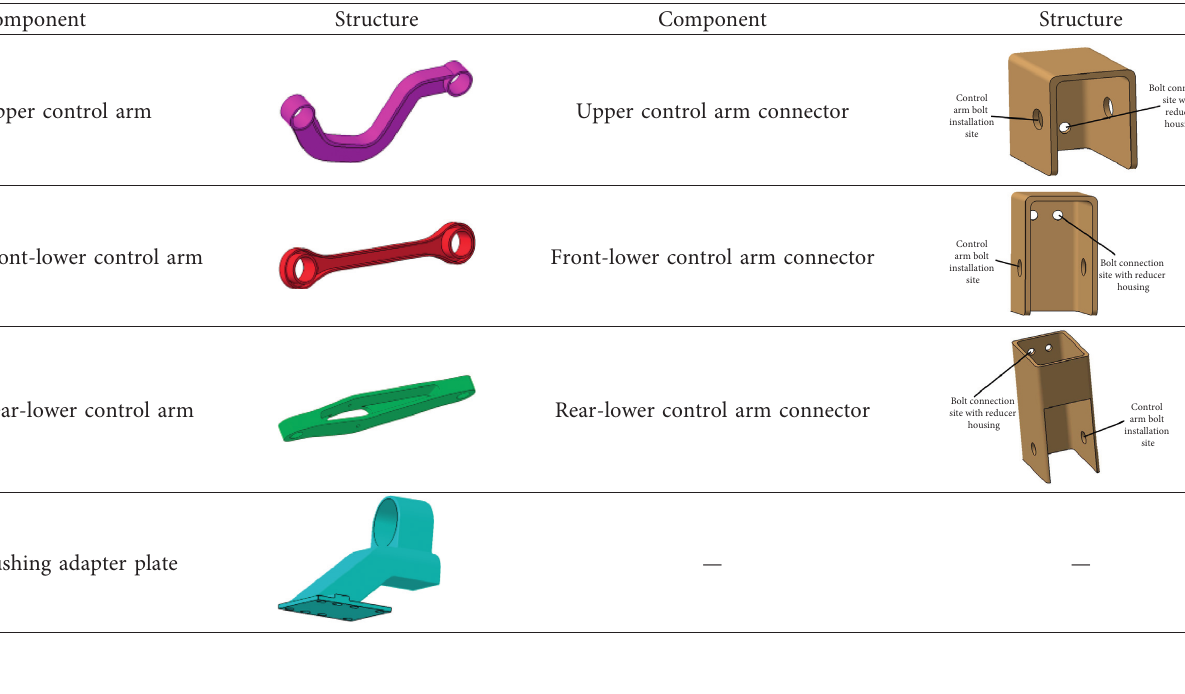
Table 14: Overall vehicle parameters.